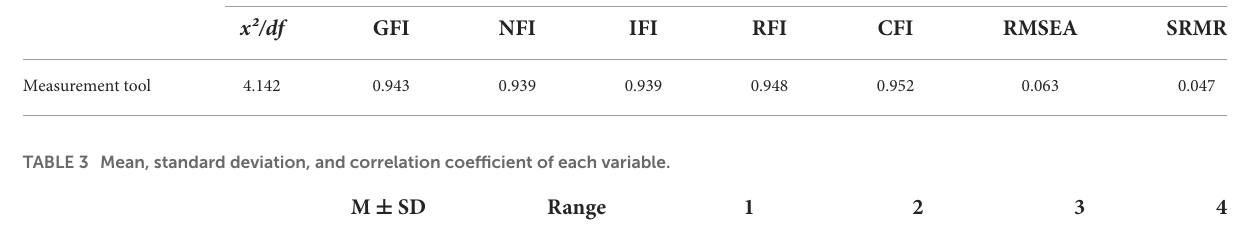
TABLE 2 Confirmatory factor analysis of the whole set of measurement tools. Variable